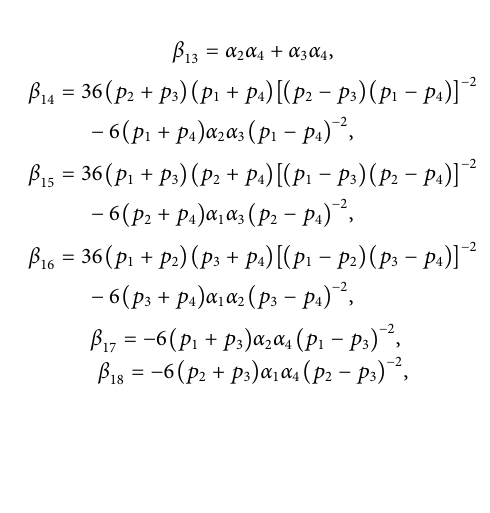
: (A) t = − 1; (B) t = 0; (C) t = 1; (D) , (E) , (F) are the density plot of (A) , (B) , (C) 2